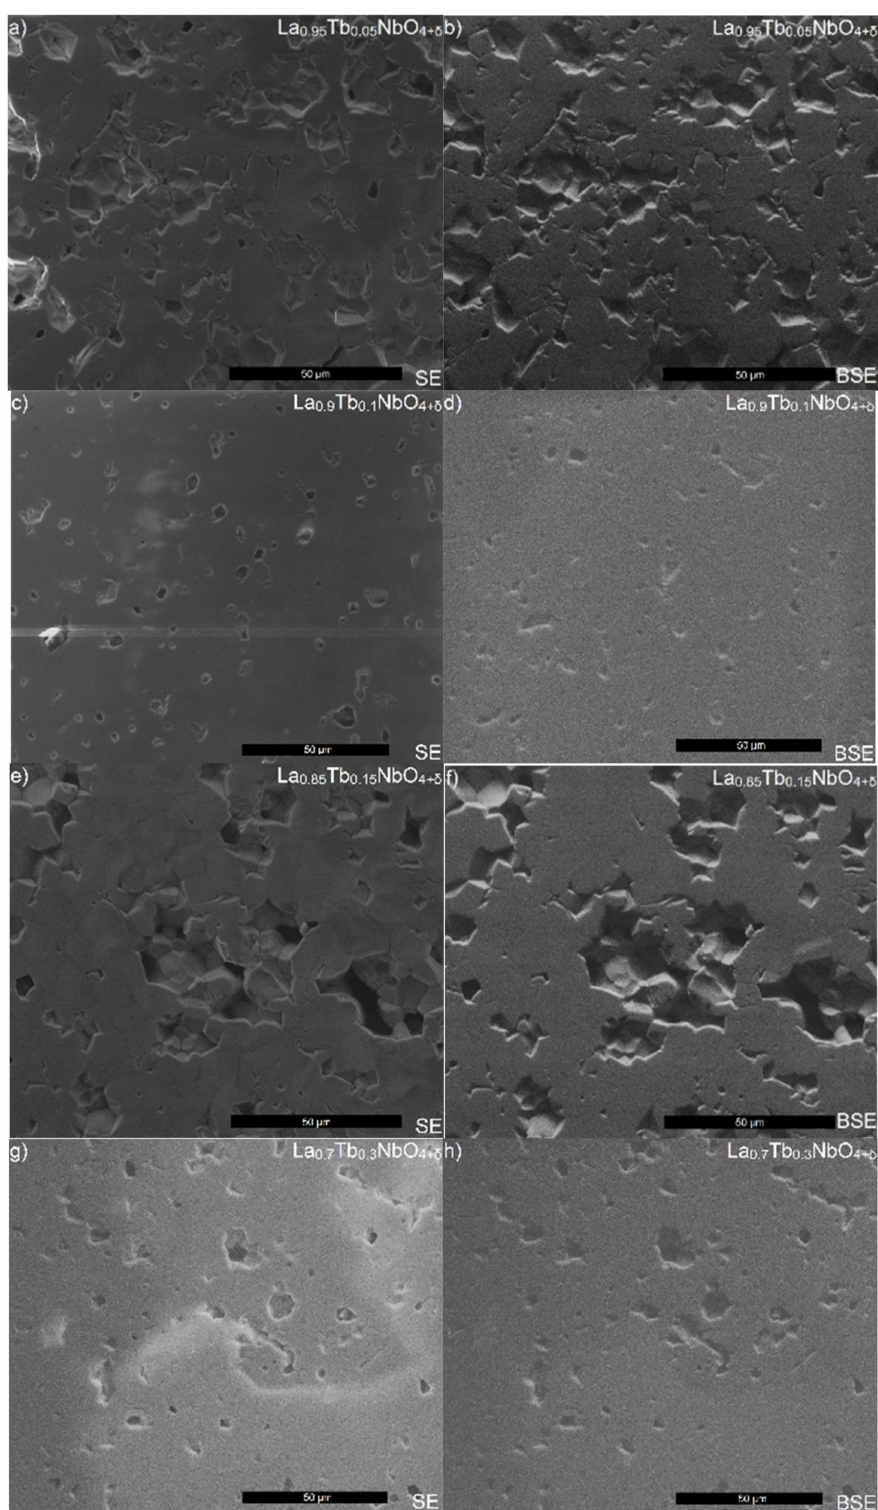
Figure 4. SEM image of polished fractures of La 0.95 Tb 0.05 NbO 4+ δ , La 0.9 Tb 0.1 NbO 4+ δ , La 0.85 Tb 0.15 NbO 4+ δ , La 0.7 Tb 0.3 NbO 4+ δ taken in SE and BSE